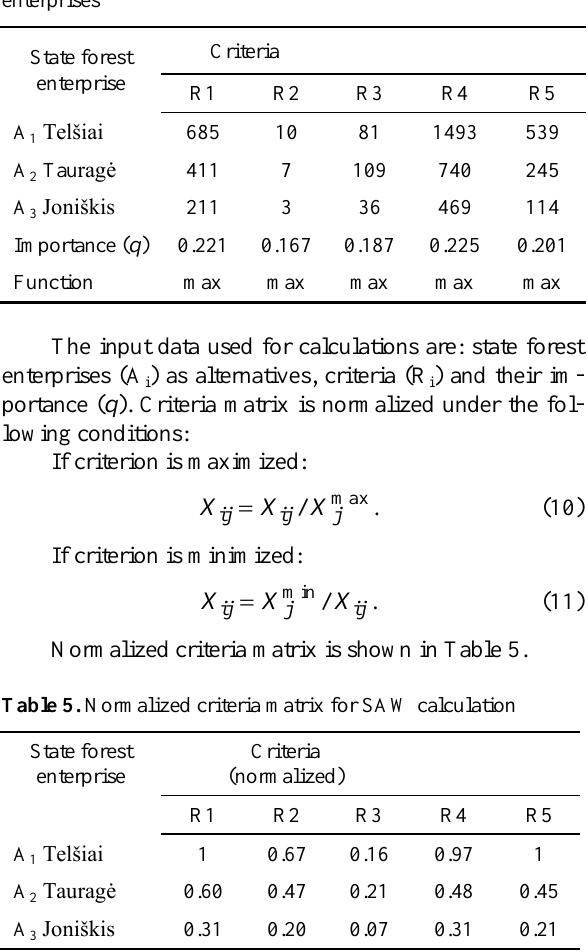
Table 4. Fragment of forest fragmentation statistical data (area of forest fragmentation component (ha)) within state forest